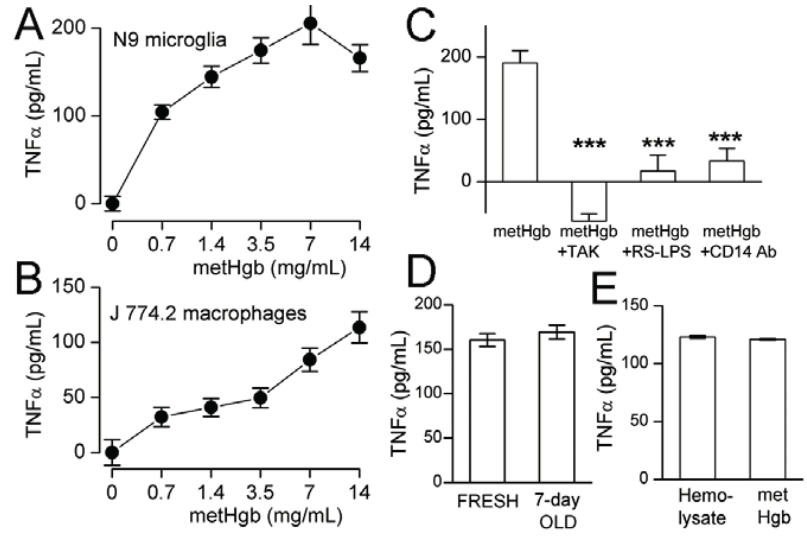
Figure 5. metHgb causes dose-dependent, TLR4-dependent secretion of TNF α from microglia and macrophages. ( A , B ) Cultured N9 microglia ( A ) and J 774.2 macrophages ( B ) were exposed to purified LPS-free metHgb at the concentrations indicated on the abscissae; ( C ) Cultured N9 microglia were exposed to purified LPS-free metHgb (7 mg/mL) without or with TAK-242 (2 µM), or Rs-LPS (10 µM), or anti-CD14 antibody (10–50 µg/mL), as indicated; ( D ) Cultured N9 microglia were exposed to purified LPS-free metHgb (7 mg/mL), either freshly prepared or stored in solution under anaerobic conditions at 37 °C for 7 days; ( E ) Cultured N9 microglia were exposed to LPS-free hemolysate (7 mg/mL) or purified LPS-free metHgb (7 mg/mL). In all cases ( A – E ), TNF α secretion into the medium was measured at 24 h by ELISA; for ( A , B , D , E ), 3 replicates per condition; for ( C ), 4–8 replicates per condition; *** p < 0.001.